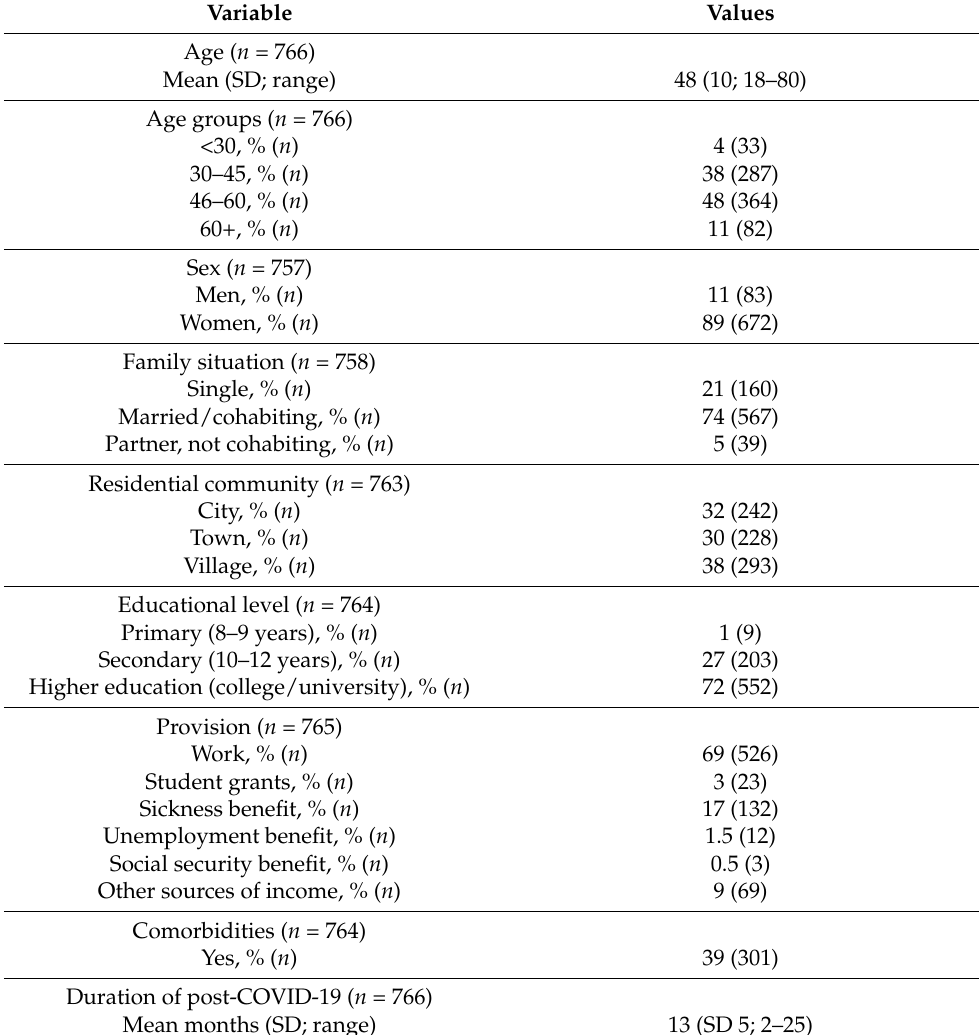
Table 1. Characteristics of the study sample ( n =